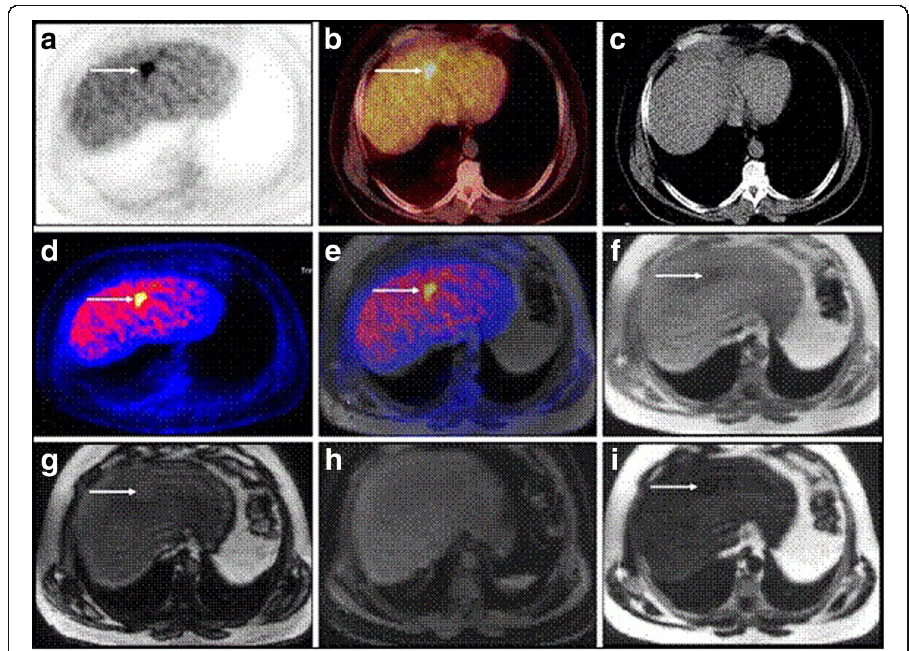
Fig. 7 Set of images in a 48-year-old patient with a liver metastasis from sigmoid cancer. High liver uptake is found both in PETAC_CT ( a ) and PETAC_MR ( d ), whereas image fusion with low-dose CT ( b ) and Dixon T1w ( e ) allow for better anatomical correlation. In low-dose CT due to its low soft tissue contrast no anatomical correlate for the liver metastasis could be found ( c ). Figures from ( f ) to (I) present the different sets created from the raw data of the Dixon sequence (( f ) T1w in-phase, ( g ) T1w out-of-phase, ( h ) water-only and ( i ) fat-only). The complementary value of different reconstructions can be appreciated as the liver metastases are outlined with different quality in T1w in-phase ( f ), T1w out-of-phase ( g ) and fat-only ( i ).No correlate can be found in the water-only image ( h ) (This research was originally published in M. Eiber et al., “ Value of a Dixon-based MR/PET attenuation correction sequence for the localization and evaluation of PET-positive lesions, (Eiber et al. 2011) ” Eur. J. Nucl. Med. Mol. Imaging, vol. 38, no. 9, pp. 1691 – 1701, 2011.© by the Society of Nuclear Medicine and Molecular Imaging,